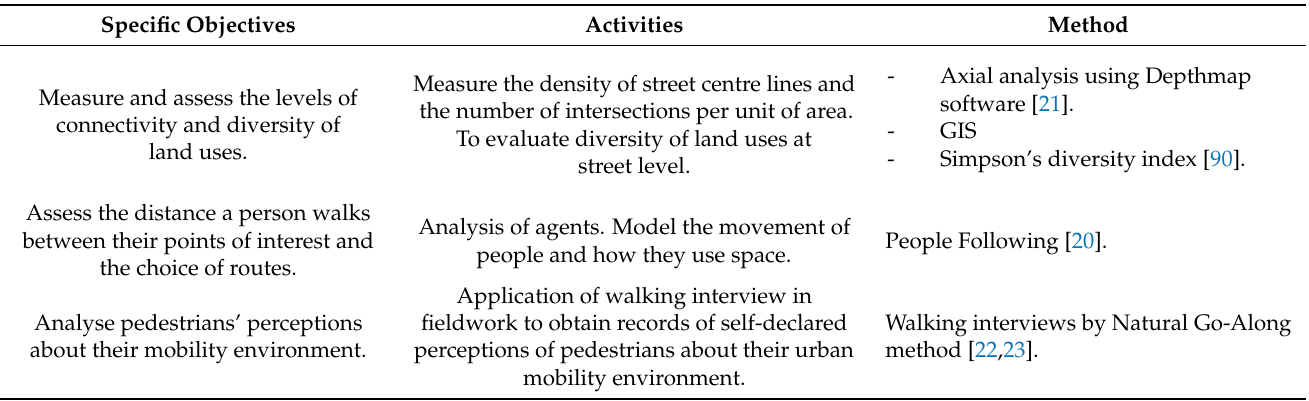
Table 1. Methodological structure.